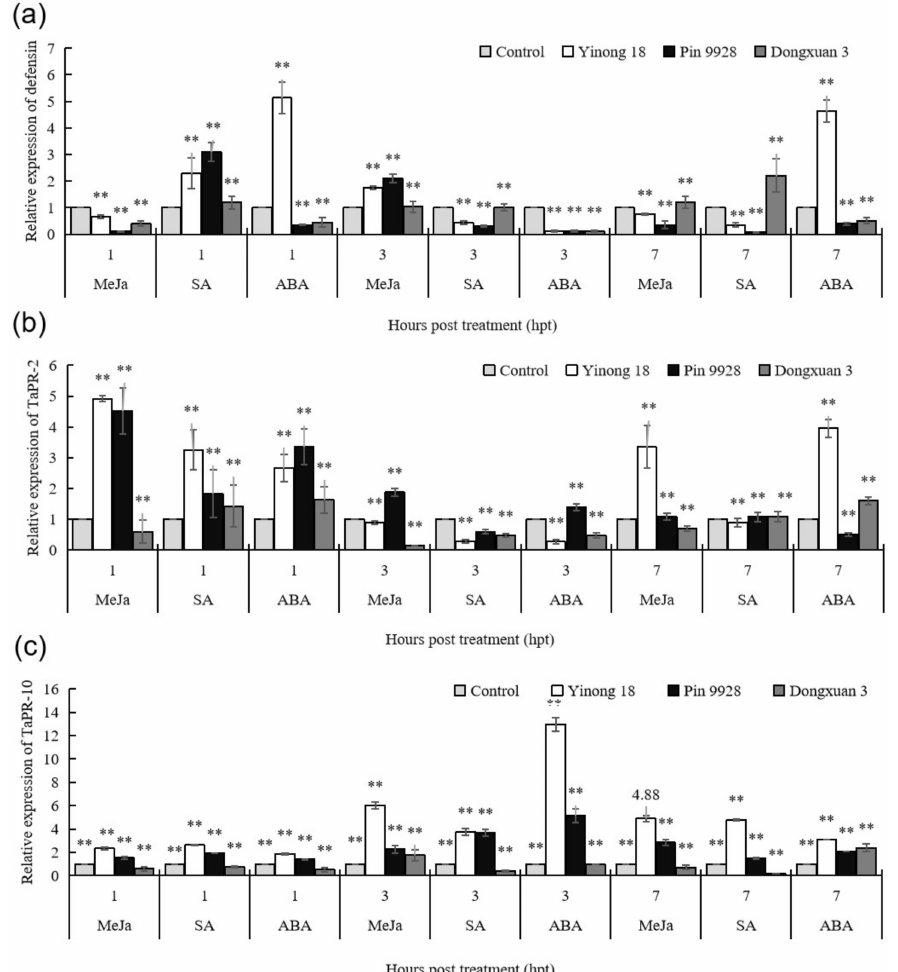
Figure 2. Transcriptional patterns of defensin, TaPR-2 and TaPR-10 after treatment with hormones. The resistant (Yinong 18), moderately resistant (Pin 9928) and susceptible (Dongxuan 3) wheat cultivars were sprayed with Methyl jasmonate (MeJa), salicylic acid (SA), and abscisic acid (ABA). The plants treated with ddH 2 O were used as control in the study. ( a ) relative expression of defensin; ( b ) relative expression of TaPR-2; ( c ) relative expression of TaPR-10 . The significant differences were statistically analyzed based on three biological replications and four technical replications (Tukey’s test: ** p < 0.05). Bars indicate the standard